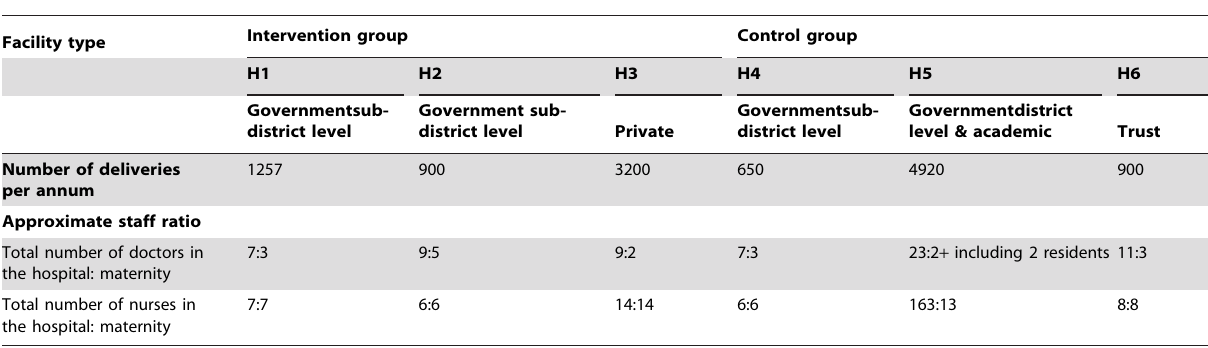
Table 1. Characteristics of study